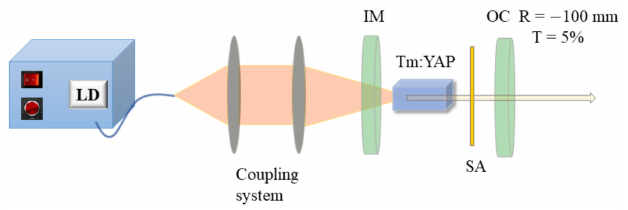
Figure 2. The schematic of the 2- µ m pulsed laser experimental setup. LD is laser diode, IM is the input mirror, Tm:YAP is the laser crystal, SA is saturable absorber, OC is the output coupling concave mirror with radius curvature of 100 mm (R = − 100 mm) and transmissivity of 5% (T = 5%). First, the output power of the CW Tm:YAP laser was maximized by adjusting the cavity under 3.91 W pump power. The cavity was then fixed to survey the influence of pump power on the output power. The output power reached 198 mW with a slope efficiency of 7.3% under 5.2 W launched pump power, as shown in Figure 3. Mo:BiVO 4 SA was then inserted into the cavity. A stable Q-switched laser (QSL) was achieved. Due to the insertion of SA, the loss of the cavity in QSL was higher; thus, the output power of Tm:YAP laser in QSL operation was lower than that in CW operation. Under QSL operation, 153 mW average power was acquired with a slope efficiency of 5.1%.